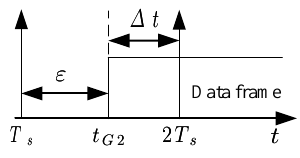
Figure 4. Signal arrival